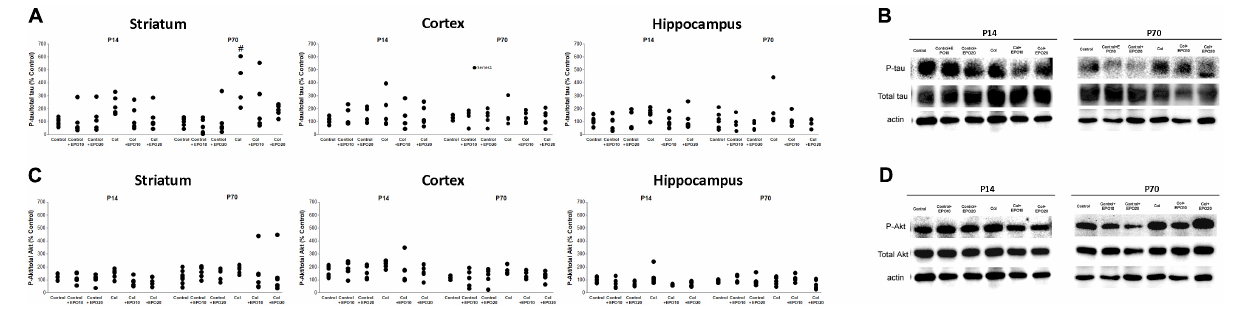
FIGURE 4 | EPO treatment reduces tau and Akt phosphorylation after Col lesions. (A) Increased tau phosphorylation after Col lesions was reduced after EPO treatment at P14 although differences did not reach statistical significance (striatum: p = 0.193; cortex: p = 0.922 and hippocampus: p = 0.504]). A similar profile was observed when we analyzed animals in the long term (P70) (striatum: # p = 0.023 vs Control + EPO20; cortex: p = 0.658 and hippocampus: p = 0.522). (B) Illustrative example of phospho-tau/total tau striatum westerns blots at P14 and P70, showing an increased phosphorylation after Col lesions at P70, that is reduced by EPO treatment. (C) Increased phosphor-Akt/total Akt ratios after Col lesions were reduced by EPO treatment in the ipsilateral hemisphere although differences did not reach statistical significance at P14 (striatum: p = 0.127; cortex: p = 0.552; hippocampus: p = 0.055) or at P70 (striatum: p = 0.931; cortex: p = 0.425; hippocampus: p = 0.475). (D) Illustrative example of striatum phosphor-Akt/total Akt western blots at P14 and P70, after EPO